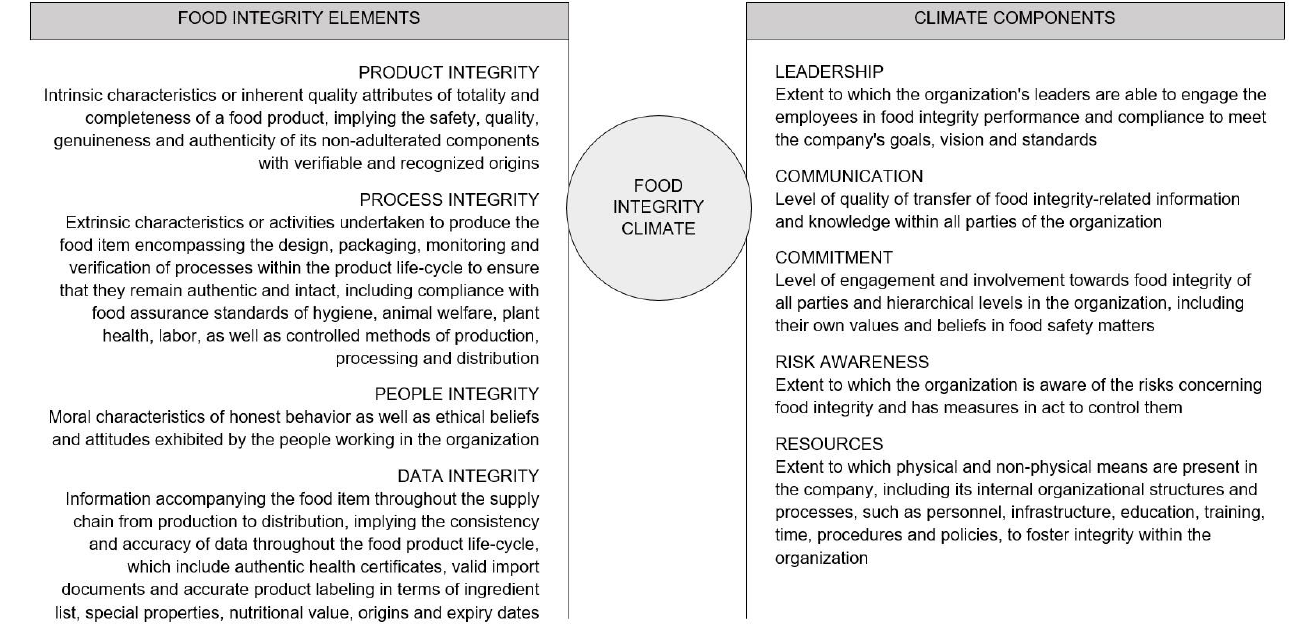
Figure 2. Conceptual model of the food integrity climate. The concept of a food integrity climate is constituted by the combination of food integrity elements (product, process, people, and data integrity) [8] and the components of a company’s climate (leadership, communication, commitment, risk awareness, and resources) [16].